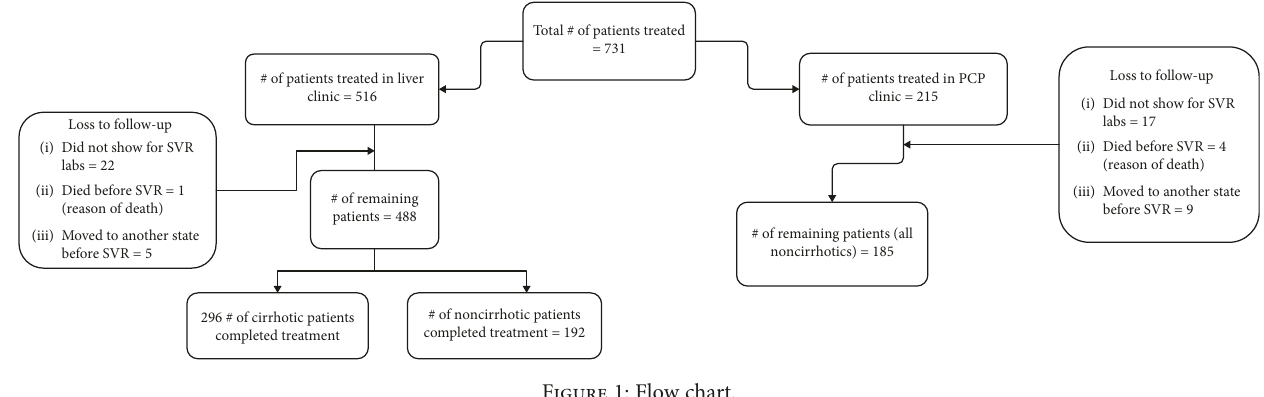
Figure 1: Flow Table 1: Demographic values by clinic with the chi-square test or the t -test.